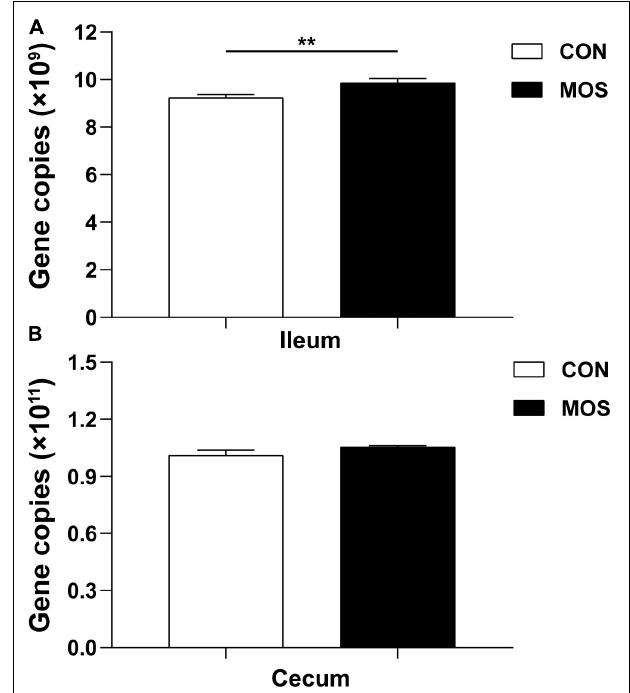
FIGURE 2 | Effects of MOS on microbial metabolites (VFA) (A) and pH values (B) of cecal digesta. Digesta samples were collected from pigs fed with the basal diet (CON) or a basal diet supplemented with 3 g/kg MOS (MOS) ( n = 8). ** p < 0.05, *0.05 < p < 0.1.